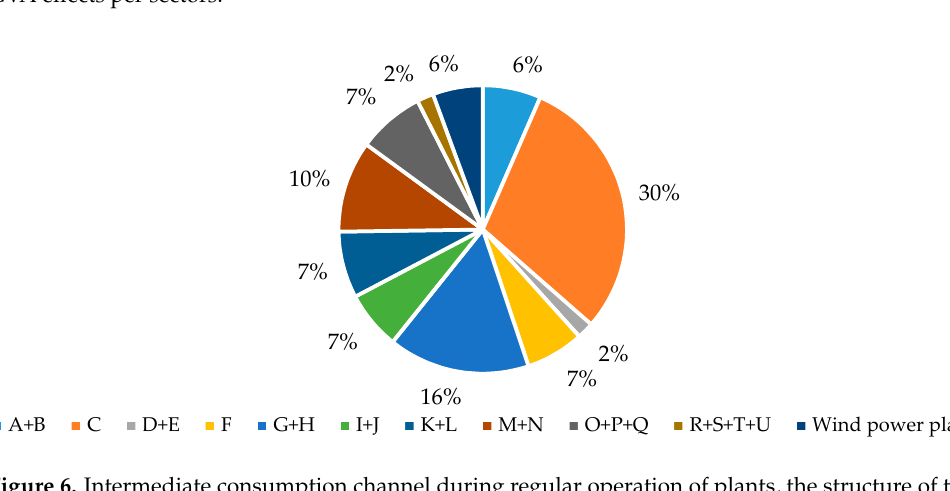
Figure 6. Intermediate consumption channel during regular operation of plants, the structure of total employment effects per sectors.